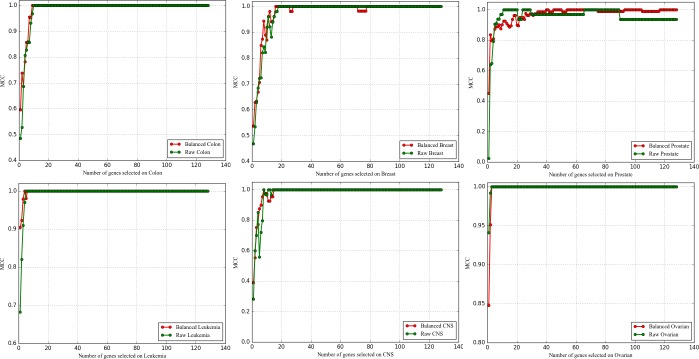
The comparison of MCC obtained on six balanced and raw datasets.